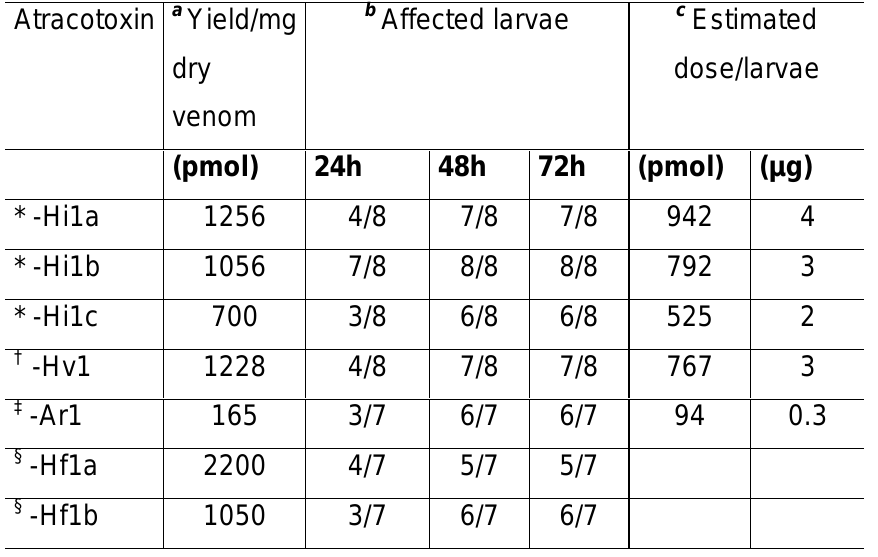
Table 1: Toxin yields and bioassay results. Atracotoxin a